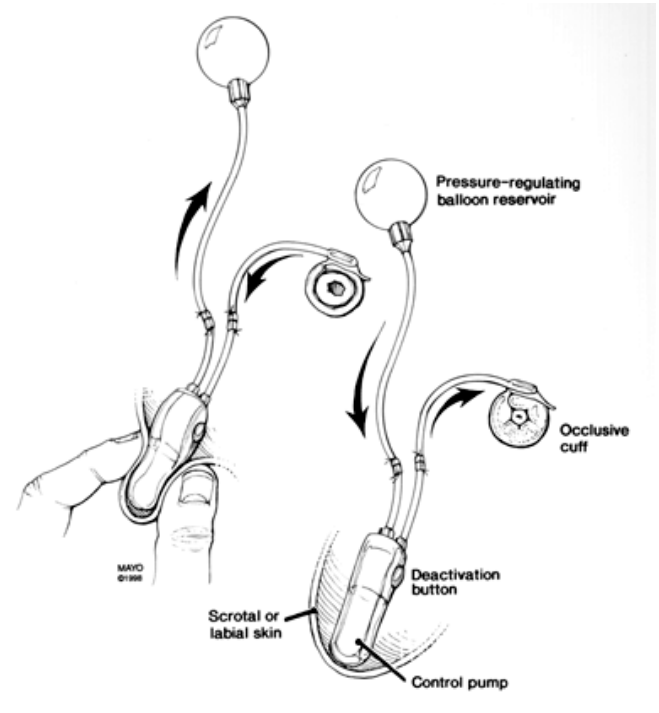
FIGURE 1. Components and cycling of the AS-800 AUS; pressure on the pump transfers fluid out of the cuff to the reservoir, the cuff then refills